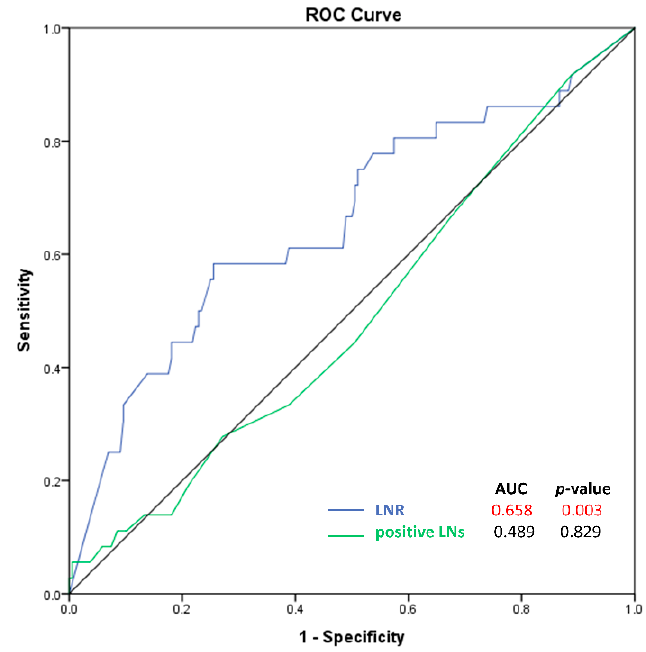
Figure 3. Receiver-operator characteristic curves for lymph node ratio and the number of positive Figure 3. Receiver ‐ operator characteristic curves for lymph node ratio and the number of positive lymph nodes. lymph nodes.